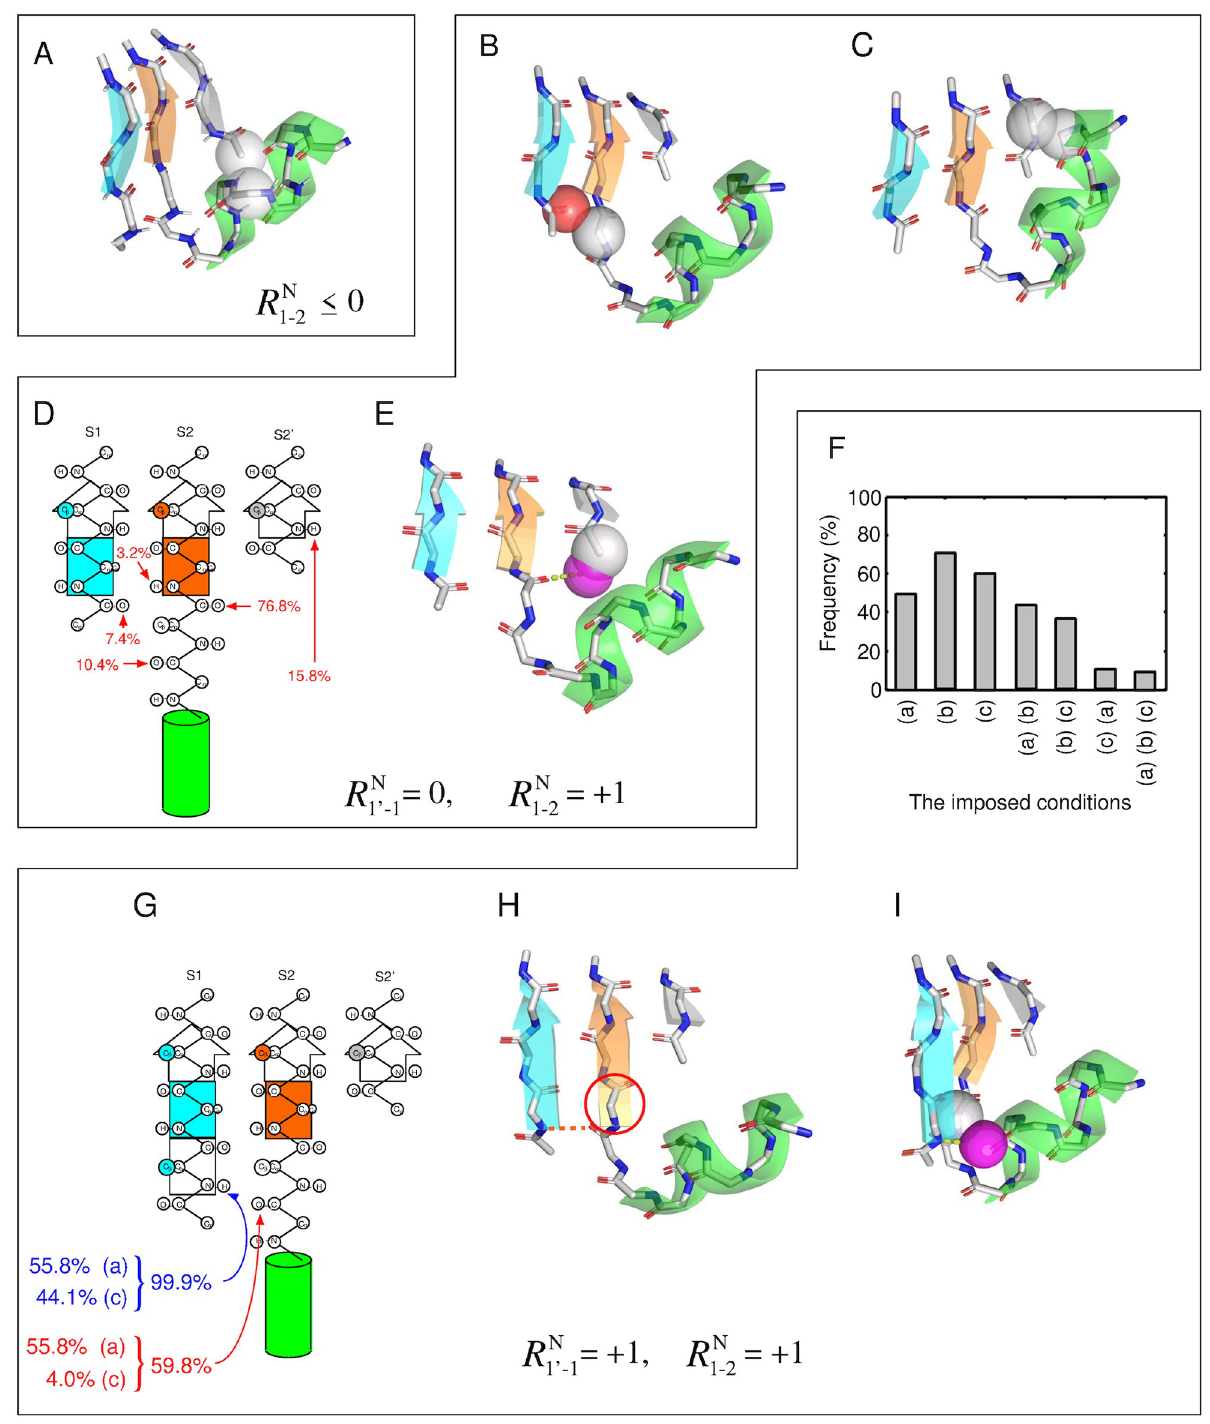
Fig 8. Disfavored structures of a GB loop with various three-stranded β -sheets identified by the simulation. The structures are categorized according to their register shifts. (A) Conformation of the system V exhibiting inter-atomic collision between the helix and S2’. This atomic collision was one of the dominant factors for the decrease of structures satisfying the condition (b) not only in the system V, but also in the systems with � 0 . (B)-(D) Disfavored conformations of the system VIII. (B) Conformation with inter-atomic collision between S1 and the GB loop and (C) R N 2 (cid:0) 2 0 that between the helix and S2’. (D) Unsatisfied polar groups and their frequencies of unsatisfaction. (E) Conformation in which the most frequently unsatisfied hydrogen bond donor did not meet the hydrogen bond satisfaction condition. (F)-(I) Disfavored conformations of the system IX. (F)